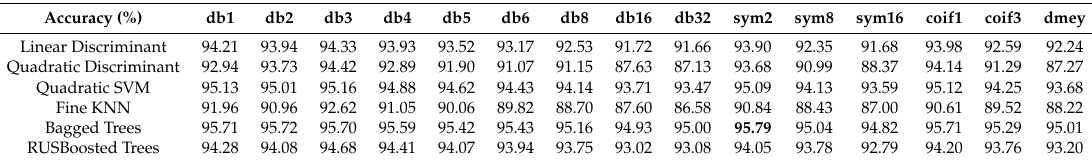
Table 5. Comparison of different classifiers in two class classification with different wavelet. The n DSSM = 6. Highest values are highlighted in